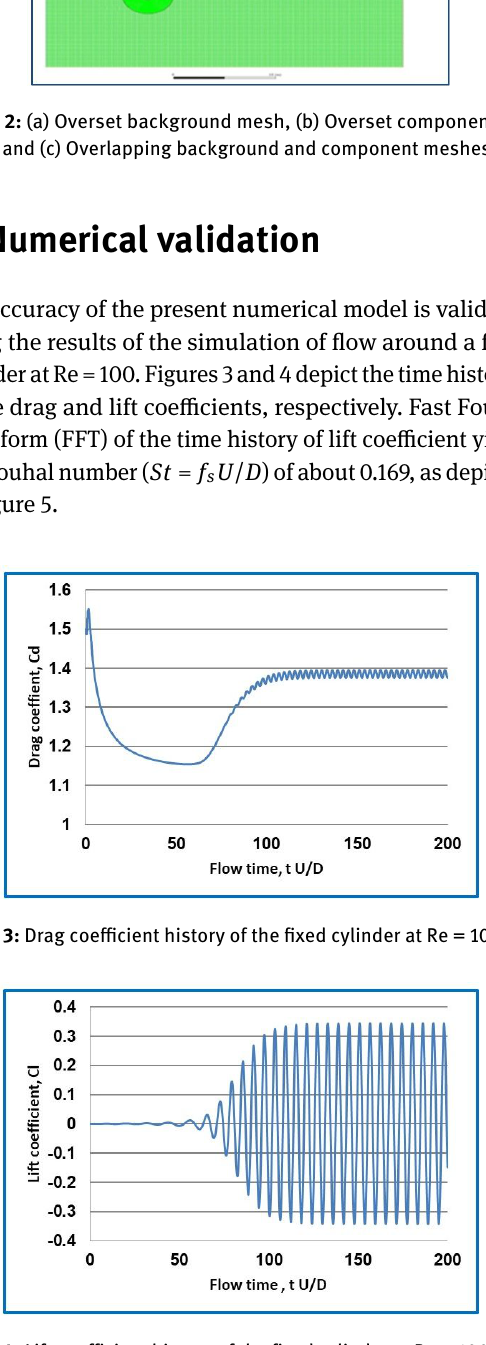
Figure 4: Lift coeflcient history of the fixed cylinder at Re =